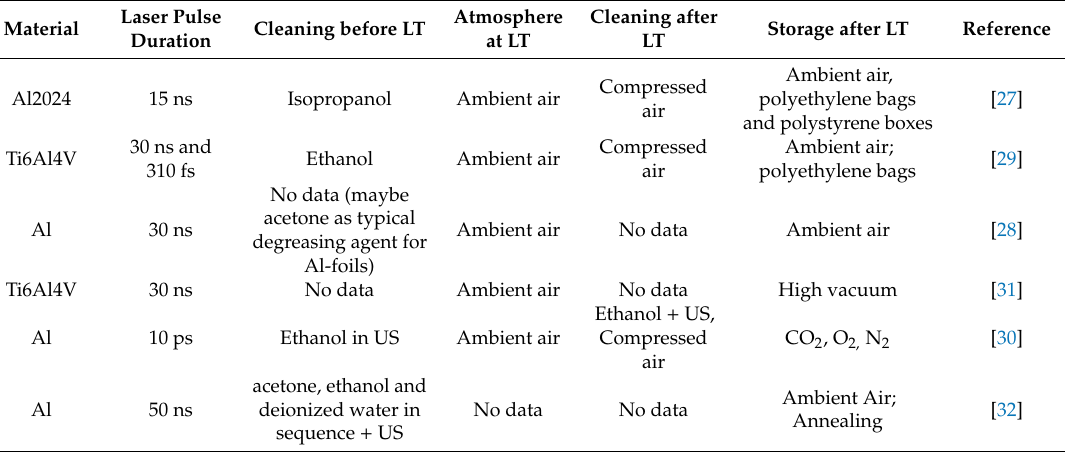
Table 1. Comparison of the usage of chemical solvents before and after laser treatment (LT) on metals in exemplary studies with focus on chemical altering of structured surfaces. US indicates the usage of an ultrasonic bath for cleaning of the samples before or after